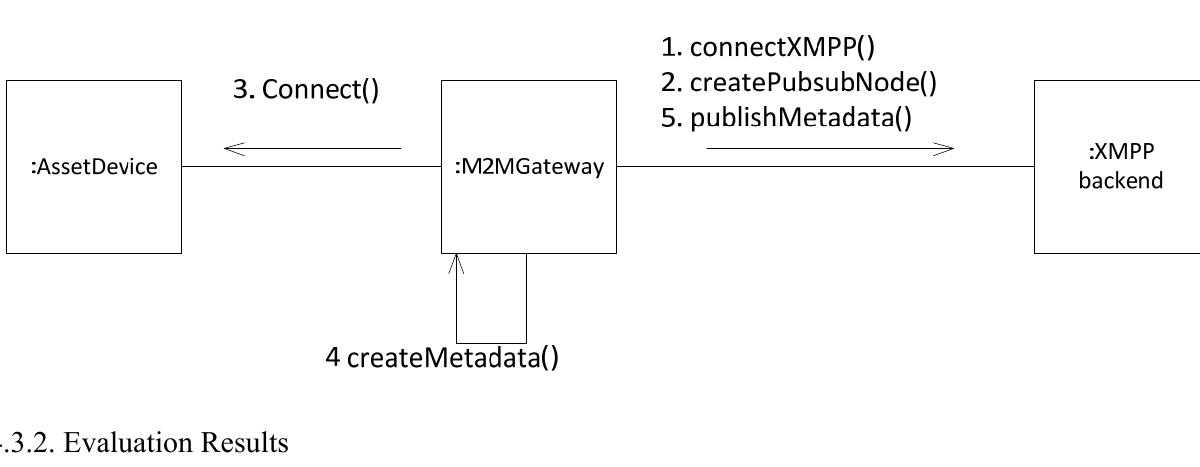
Figure 26. Connections of M2M